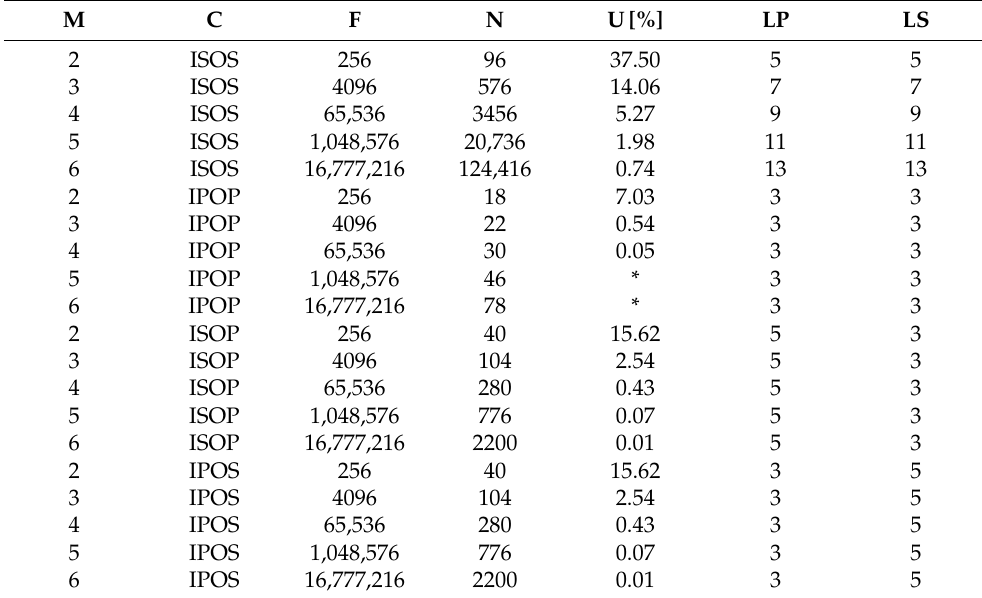
Table 4. Review of characteristics for different CHB-B2B converter